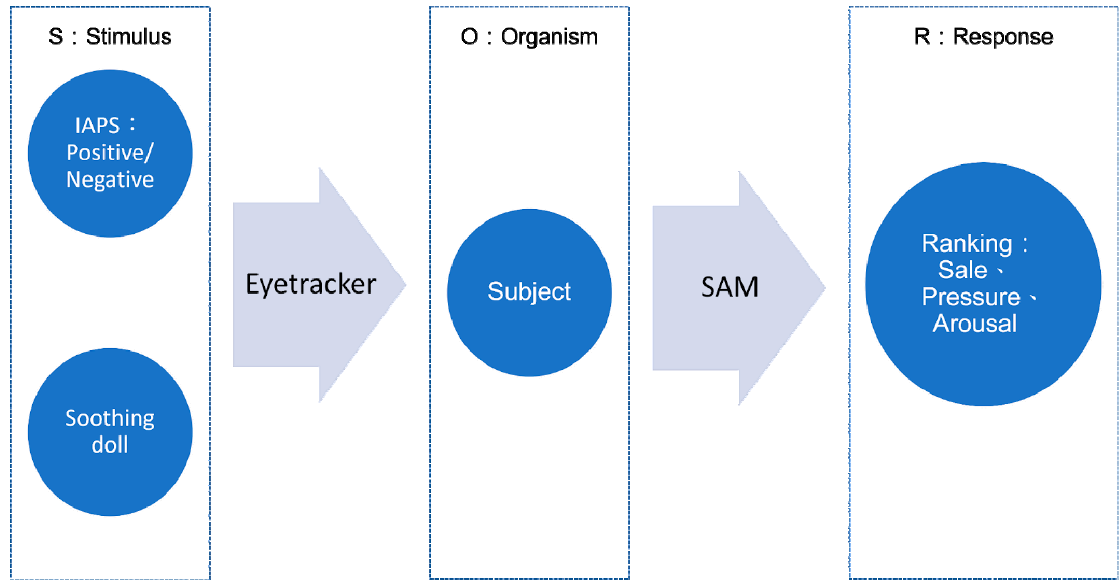
Figure 1. The modified S-O-R model for this study.